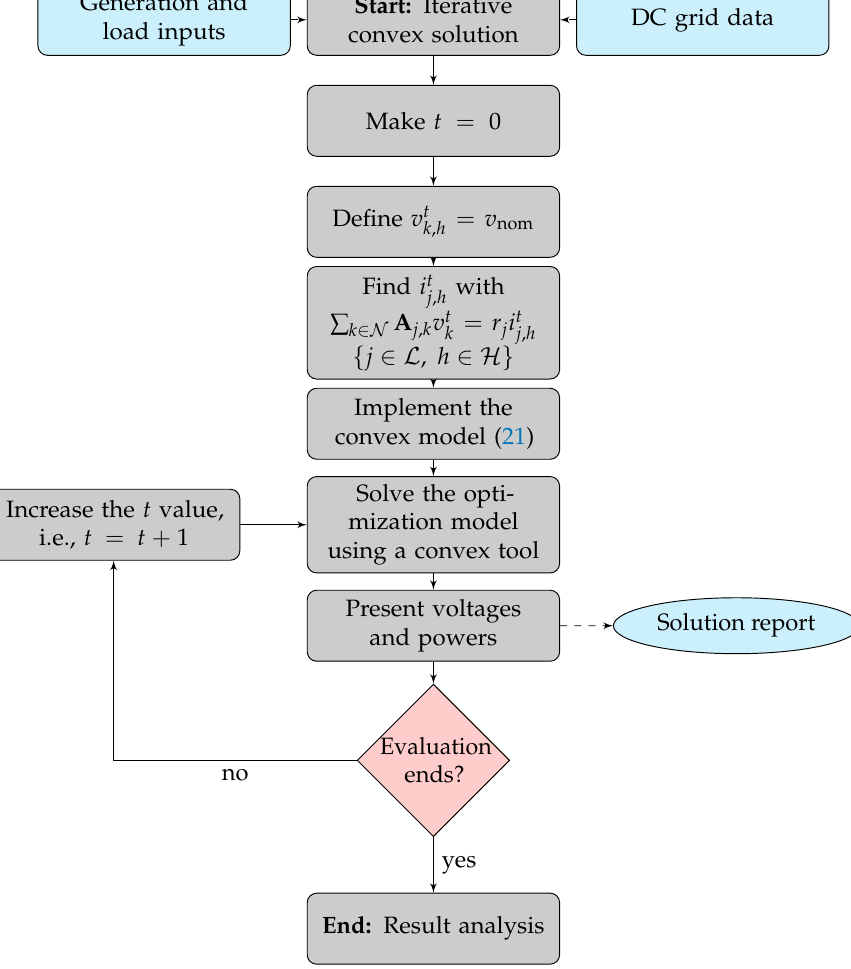
Figure 3. Iterative solution approach for the convex approximation model in